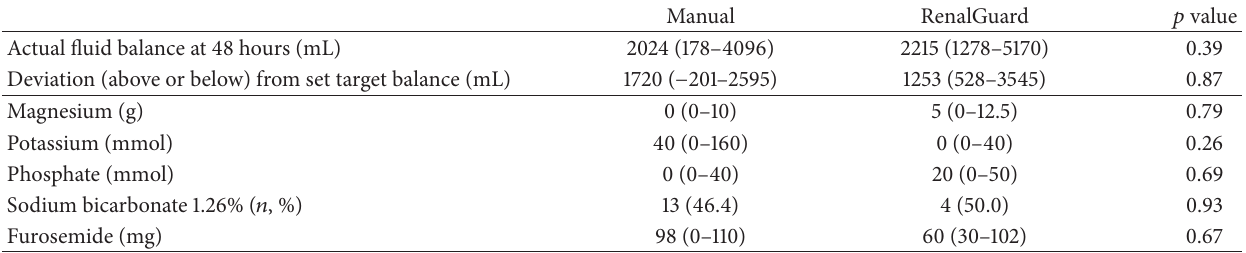
Table 3: Fluid balance, electrolyte replacement, and furosemide and sodium bicarbonate administration (median, interquartile range). Deviation from fluid balance is a delta from set target so positive and negative changes do not cancel each other out.